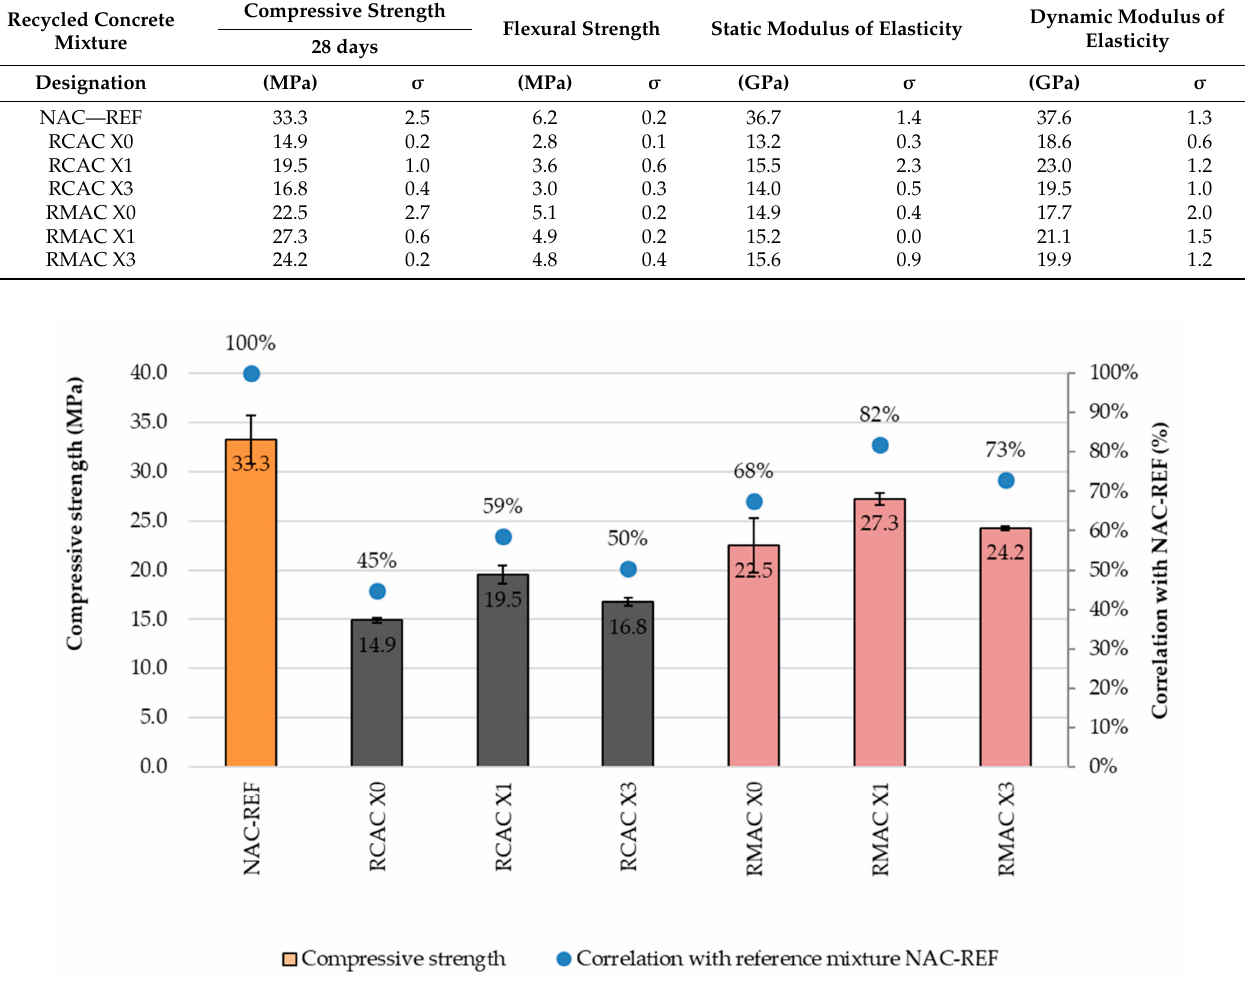
Figure 5. Comparison of compressive strength of NAC, RCAC, and RMAC at age